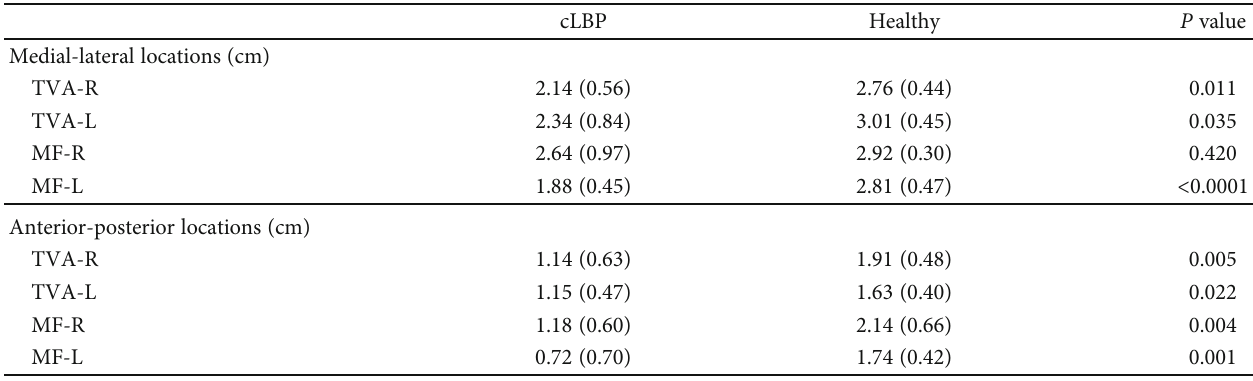
Figure 3: (a – c) Map area, map volume, and latency of TVA and MF MEP responses to TMS for the healthy and cLBP groups on the left and right hemispheres. (d) The relationship between TVA and MF in the left and right hemispheres of healthy and cLBP groups. The blue bubbles denote the CoGs of the muscles in the cLBP group, and the orange bubbles denote the CoGs of the muscles in the healthy group. cLBP: chronic low back pain; L: left; R: right; TVA: transversus abdominis; MF: multi fi dus; CoG: center of gravity. Table 2: The CoG of the medial-lateral (x-CoG) and anterior-posterior coordinates (y-CoG) in the left and right hemispheres of healthy and cLBP groups ( mean ± ð SD Þ